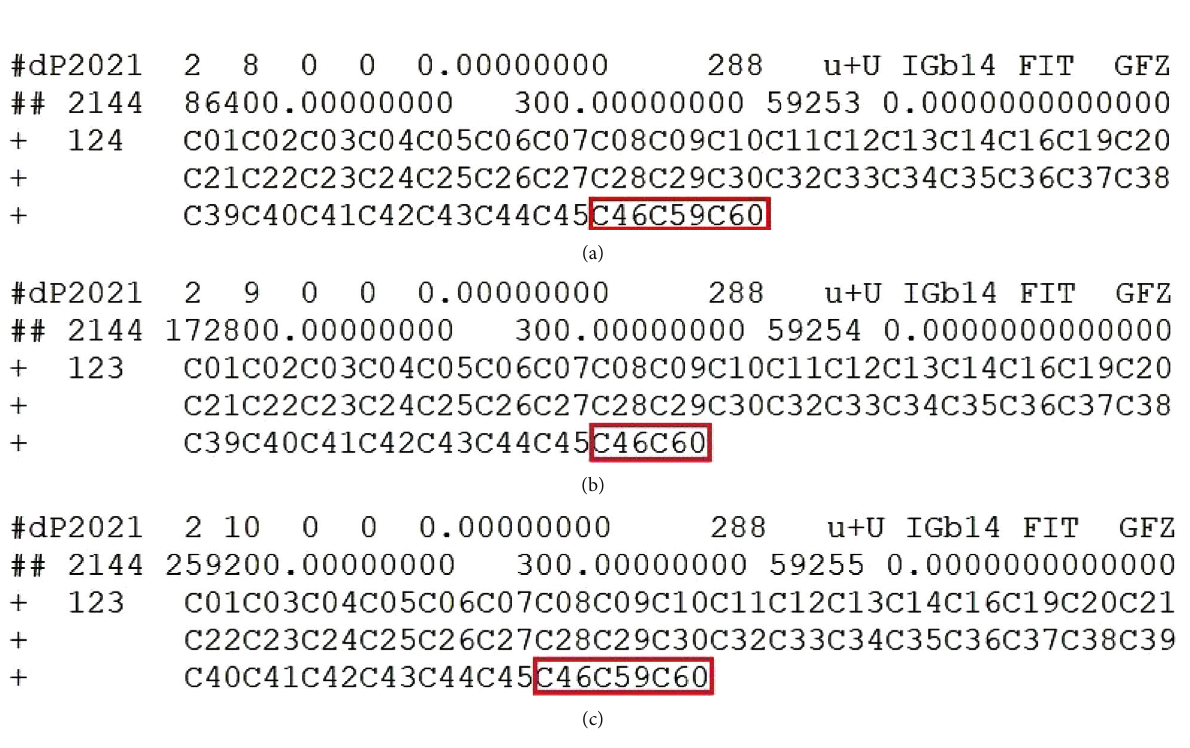
Figure 2: Precision ephemeris of BDS satellites calculated by the GFZ on February 8 (a), 9 (b), and 10 (c), 2021.